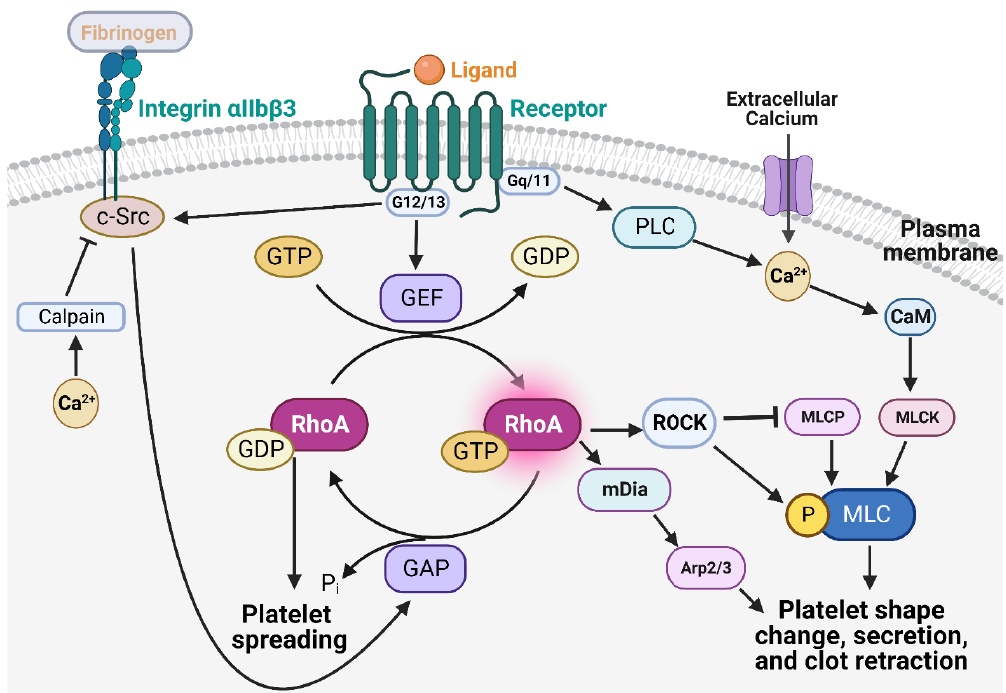
Figure 2. Role of RhoA in platelet activation and aggregation. RhoA works downstream of multiple G-protein coupled receptors and integrins to mediate platelet shape change, spreading, secretion, and clot retraction. Gα13 activates RhoGEF promoting RhoA -GTP formation, which eventually phosphorylates its downstream effector Myosin light chain (MLC), resulting in shape change and secretion. Gα13 also interacts with integrin αIIbβ3 to activate Src family kinases , which activate RhoGAP, which leads to RhoA inhibition, allowing platelets to spread. Calcium released during the in itial stages of platelet activation causes calpain to cleave integrin β3 inhibiting c -Src activation to promote contractility and clot retraction. In addition to Gα13, Gq /11 also contributes to platelet activation via calcium/calmodulin-mediated MLC kinase activation.